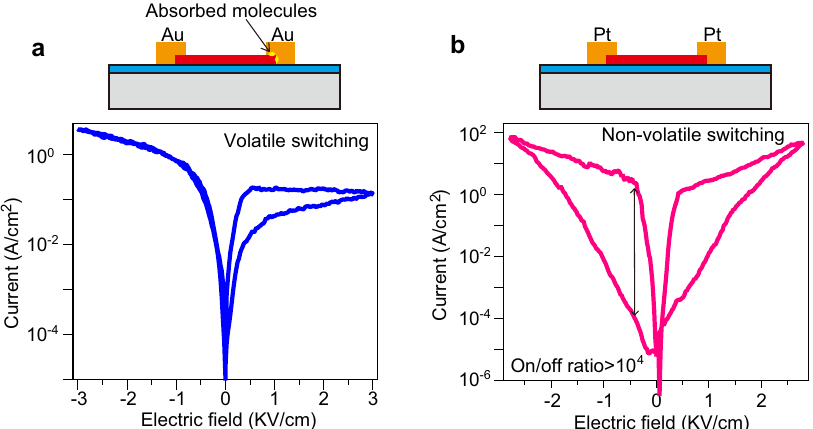
Fig. 5 Engineered interfaces for functional memory devices. a IV curves (bottom panel) for a volatile ferroelectric memristor are achieved by introducing screening charges with different quantities into two terminals as shown in the top panel. b IV curves for a nonvolatile memristor with a high on/off ratio, which is realized by the deposition of high-work function metal onto ferroelectric α -In 2 Se 3 . A great on/off switching ratio over 10 4 is demonstrated as marked by the